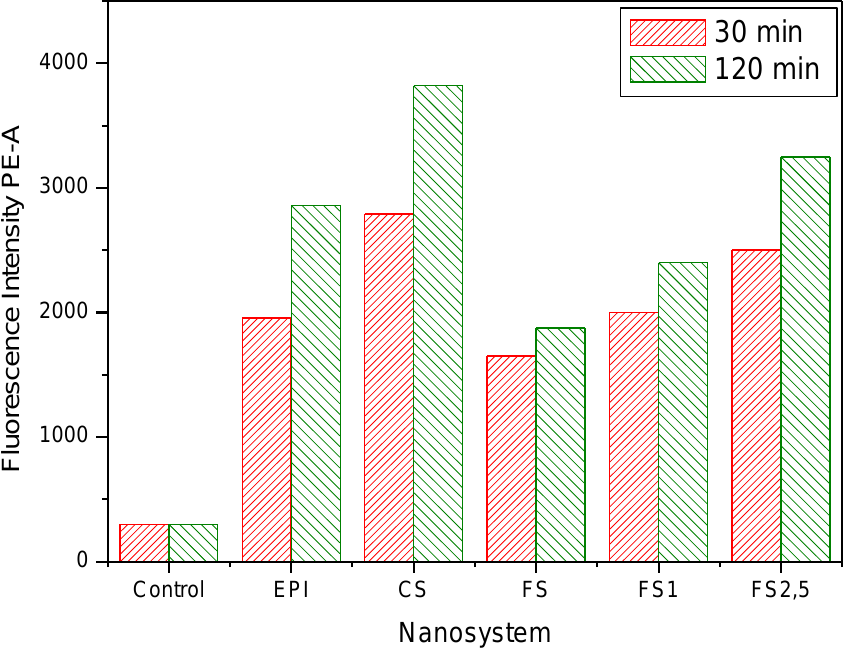
Figure 8. Relative fluorescent intensity of the MCF7 cell line when incubated with Nile-Red-loaded nanocapsules for 30 min and 2 h. Control refers to that incubation performed only with